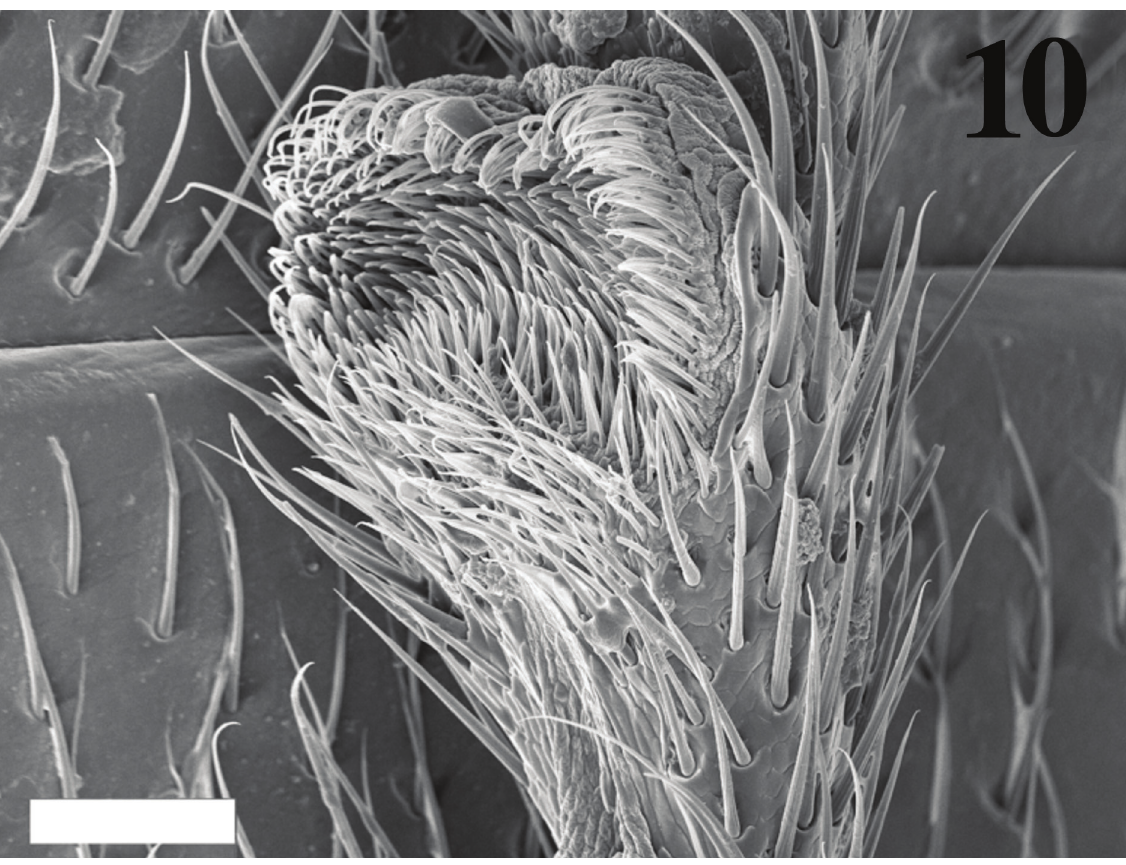
Fig. 10. Tarsomere 3 of Sharon amoenus (Philippi, 1861) comb. nov. scale bar = 0.5 mm.